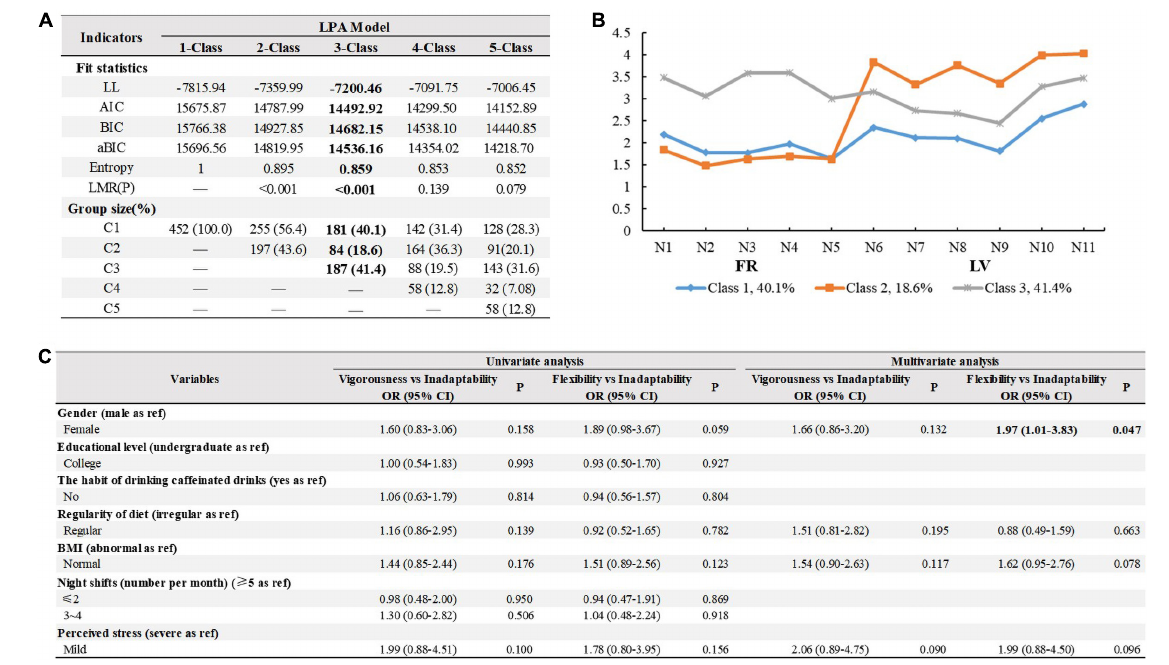
FIGURE3 Fitting index and group size of latent profile analysis models and logistic regression results for predicting external features on the 3-class pattern. (A) Fitting index and group size of latent profile analysis models. Bold figures highlight the selected class solution. LL, Log-likelihood; AIC, Akaibe information criterion; BIC, Bayesian information criterion; aBIC, adjusted BIC; LMR, Lo, Mendell, and Rubin likelihood ratio test; C1, vigorous; C2, inadaptability; C3, flexibility. (B) Parameters for the final three-class patterns. FR, flexible/rigid; LV, languid/vigorous. (C) Univariate and multivariate logistic regression results for predicting external features on the 3-class pattern. BMI, body mass index; OR, Odds ratio; CI, confidence interval. Bold figures highlight statistically significant in the multivariate logistic